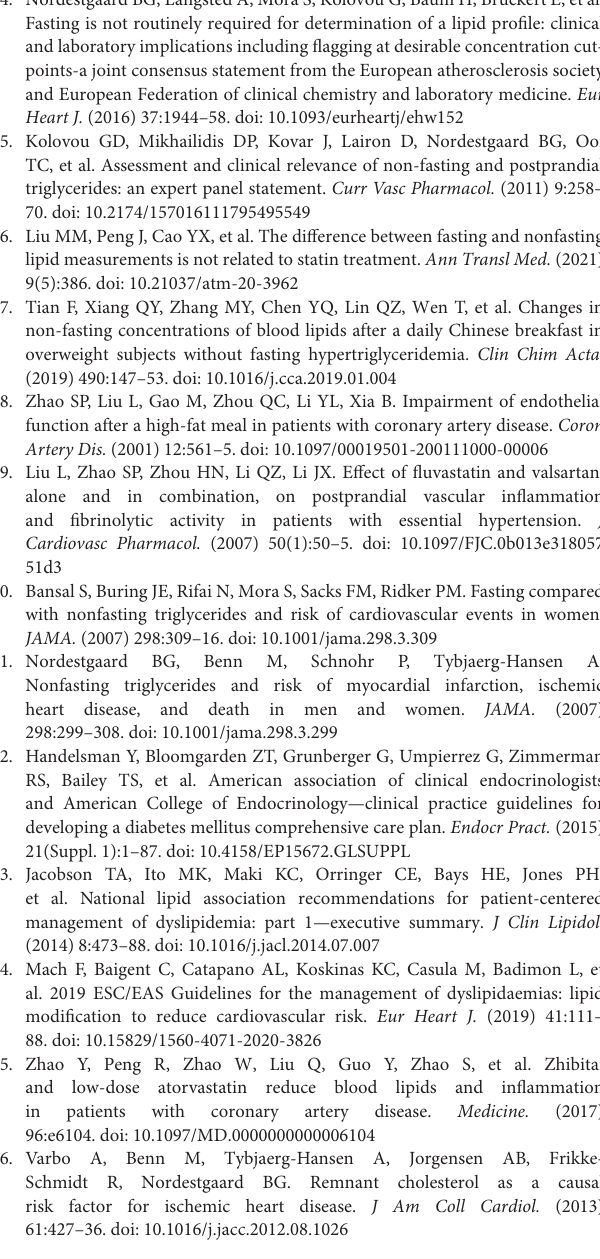
Supplementary Figure 1 | The correlation between concentrations of TG and BMI in the fasting and non-fasting state. (A) The correlation between serum concentrations of TG and BMI in the fasting state. (B,C) The correlation between serum concentrations of TG and BMI at 2h (B) and 4h (C) after a daily breakfast. Solid circles represent OW group, and open circles represent CON